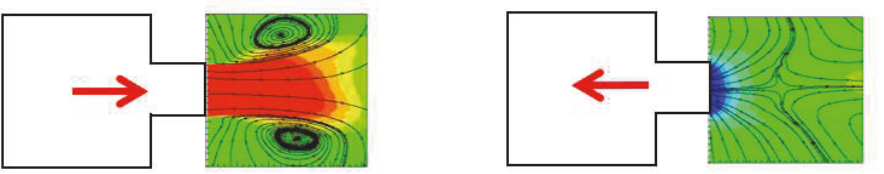
Figure 5: Pseudo-streamlines in a meridional section for two representative snapshots of the injection (left) and suction (right) phases in the ZNMF